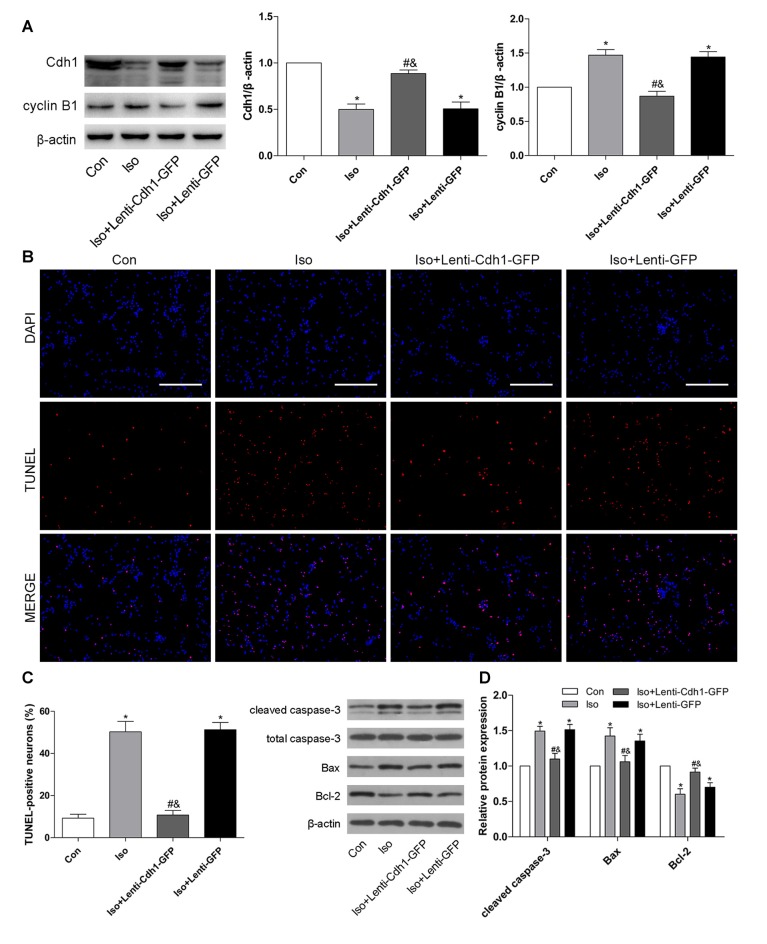
Lentivirus-mediated Cdh1 overexpression reduces isoflurane-induced neuronal apoptosis in vitro. Four groups were included in this experiment: Con, Iso, Iso + Lenti-Cdh1-green fluorescent protein (GFP), and Iso + Lenti-GFP groups. Cdh1-expressing lentivirus in the Iso + Lenti-Cdh1-GFP group and control lentivirus in the Iso + Lenti-GFP group were transfected to cultured neurons on 4 DIV for 10 h before isoflurane exposure (2%, 6 h) on 7 DIV. (A) Representative bands for the expression of Cdh1 and its downstream substrate cyclin B1 in the developing hippocampus after isoflurane anesthesia. The histograms represent the density values of Cdh1 and cyclin B1 separately. (B) Neuronal cell death was detected by TUNEL assay. TUNEL-positive cells are labeled in red, and the nucleus is stained blue. Scale bar = 200 μm. (C) The lower panel shows percentages of TUNEL-positive cells in each group. (D) After lentivirus pretreatment and isoflurane anesthesia, the expression of apoptotic proteins was analyzed by western blotting. Histograms show the quantification of each protein. *P < 0.05 vs. control group, #P < 0.05 vs. Iso group, &P < 0.05 vs. Iso + Lenti-GFP group.